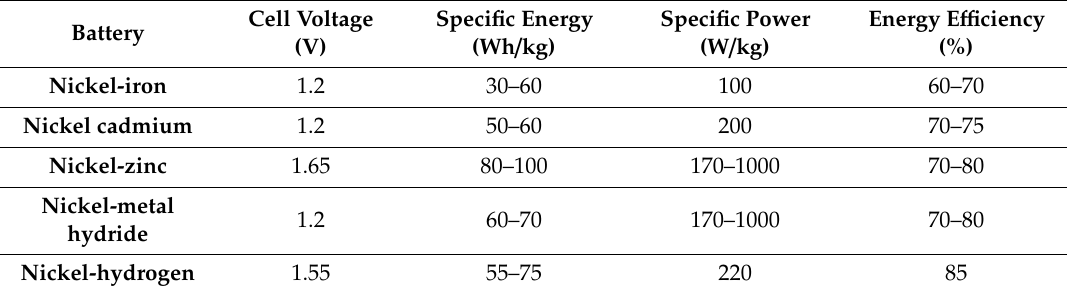
Table 10. Characteristics of nickel-based batteries